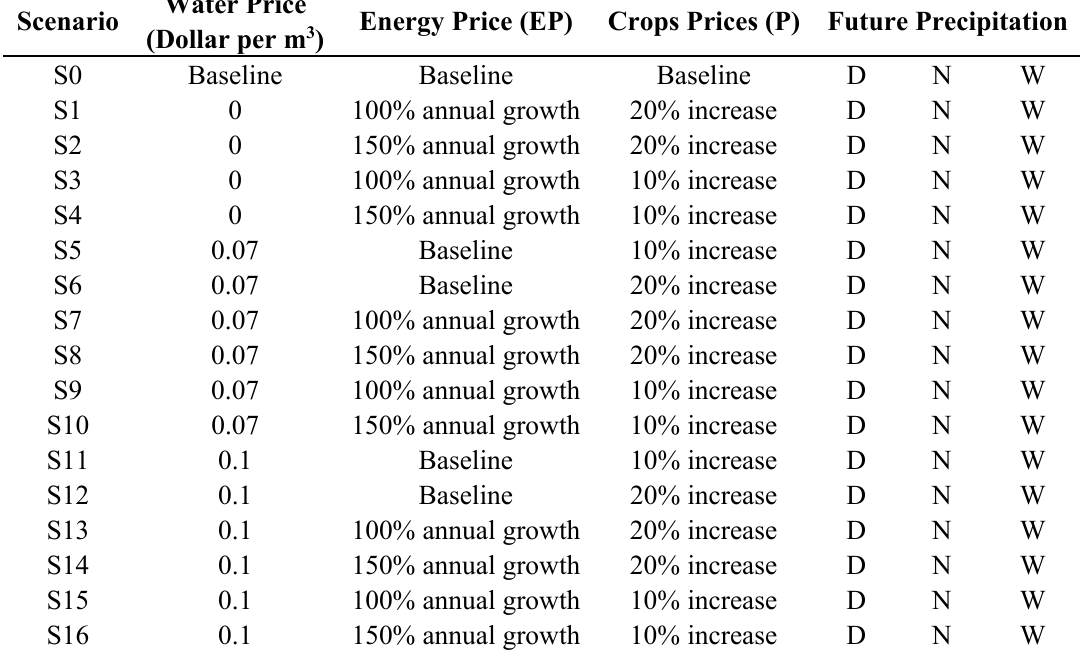
Table 1. Different integrated economic policy scenarios in agriculture